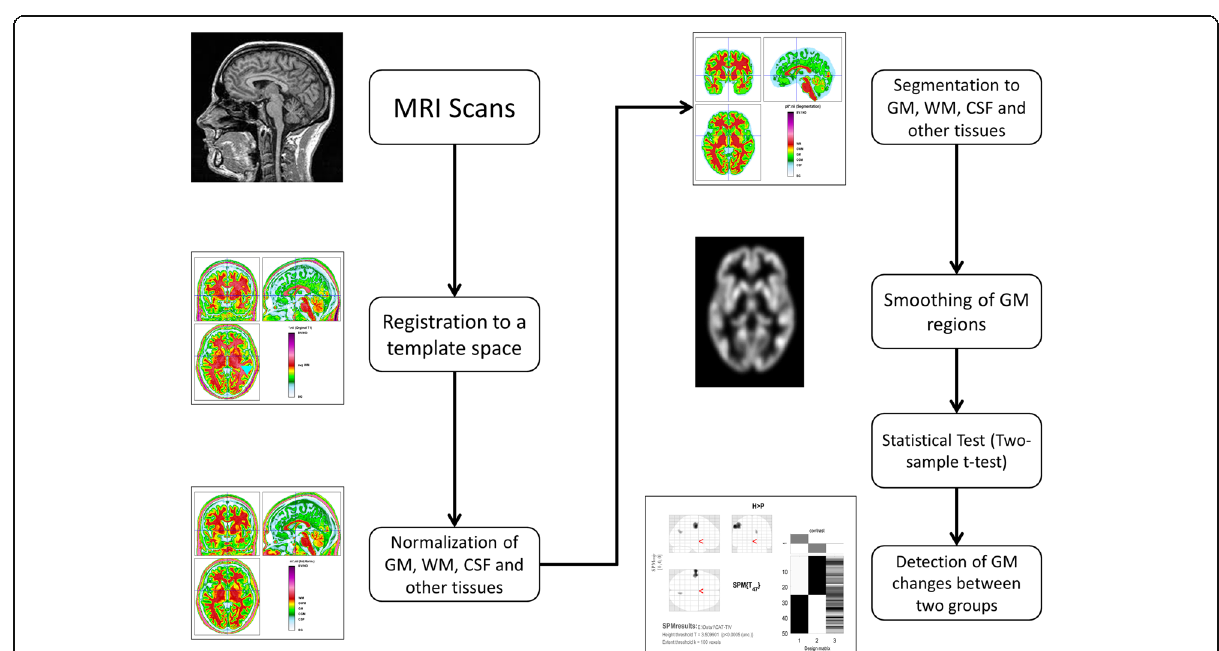
Fig. 1 The processing framework of VBM analysis using the CAT12 toolbox of SPM12